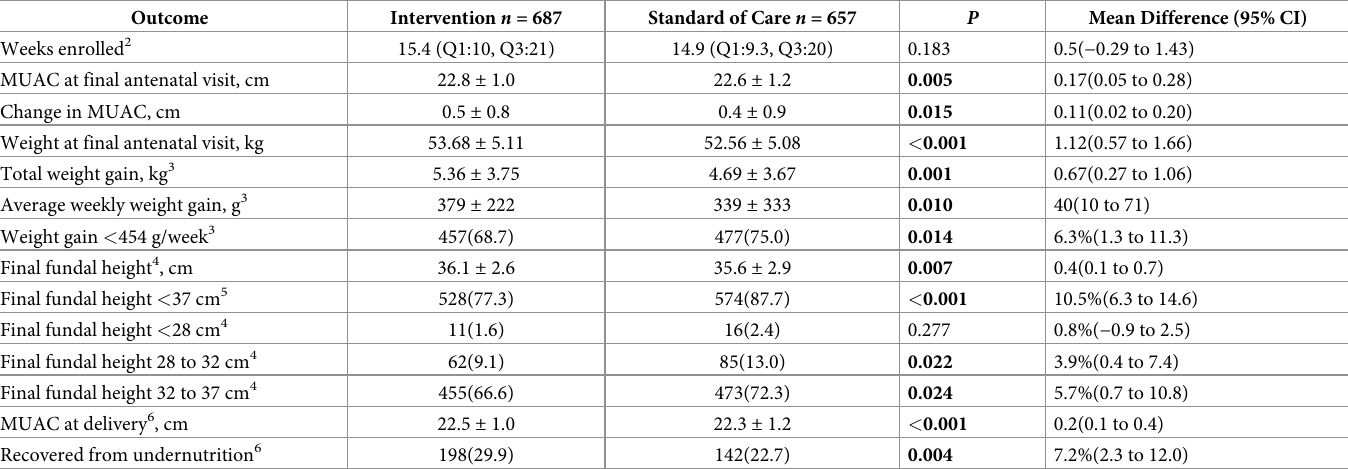
Table 2. Maternal outcomes for mothers with singleton live births, by treatment group 1